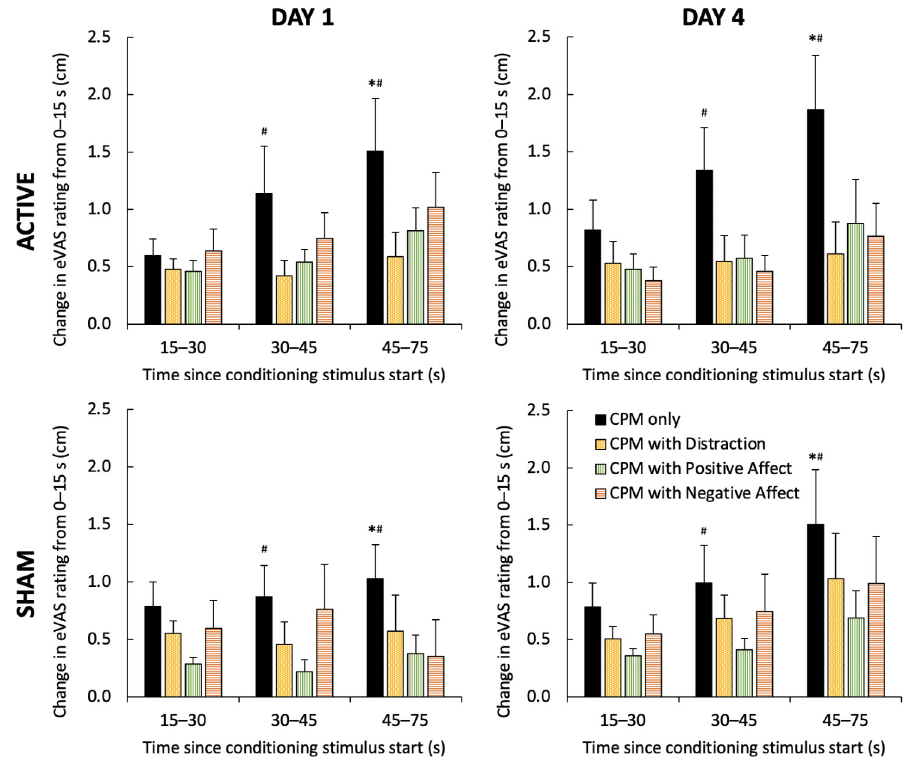
Figure 3. Increase in electronic visual analog scale (eVAS) conditioning stimulus pain intensity from first rating (normalized by subtraction) in the CPM only (black), CPM with distraction (yellow, spotted), CPM with positive affect (green, vertical), and CPM with negative affect (orange, horizontal) manipulations for each session (Active top row, Sham bottom row, Day 1 left column, and Day 4 right column). Significant increase in eVAS ratings compared to 15–30 s and 30–45 s (*, p < 0.02) and compared to all other manipulations (#, p < 0.01) indicated.